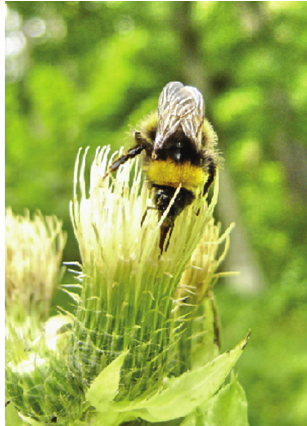
Figure 5: B. hortorum worker taking reward from Galeopsis speciosa flower, its favorite pant